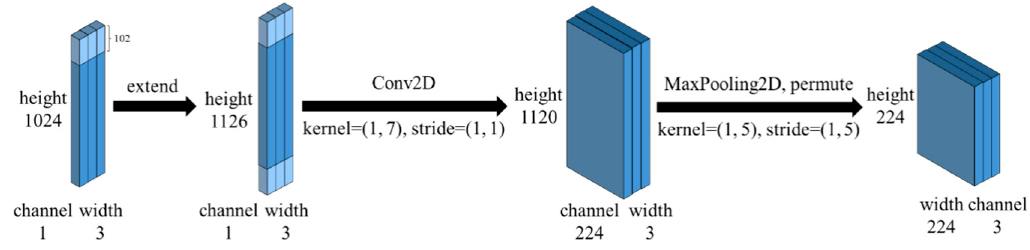
Figure 3. Schematic diagram of the convolution mapping method. The input instantaneous amplitude, instantaneous phase and instantaneous frequency are arranged into tensors with a height of 1024, width of 3 and channel of 1, respectively, and then the first 102 values of the height dimension are copied to the tail, and finally the tensors with a height of 1126 are expanded. Then, after convolution operation (the number of convolution kernels is 224), the number of output channels is expanded to 224, and then the height is reduced to 224 after pooling, and the width and channel dimension are exchanged to obtain an image with the size of 224 × 224 × 3, which is consistent with the size of images in ImageNet.